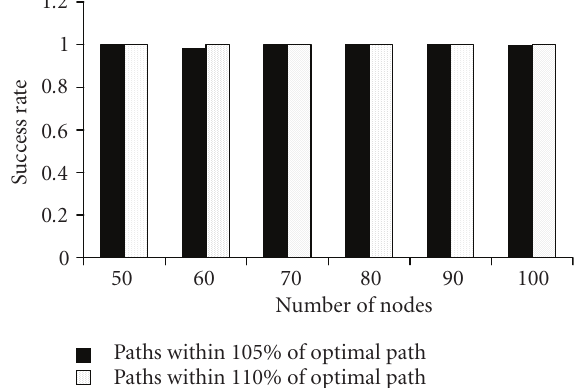
Figure 4.5 . Success rate for alternative paths that are within 105% and 110% of the optimum path cost.